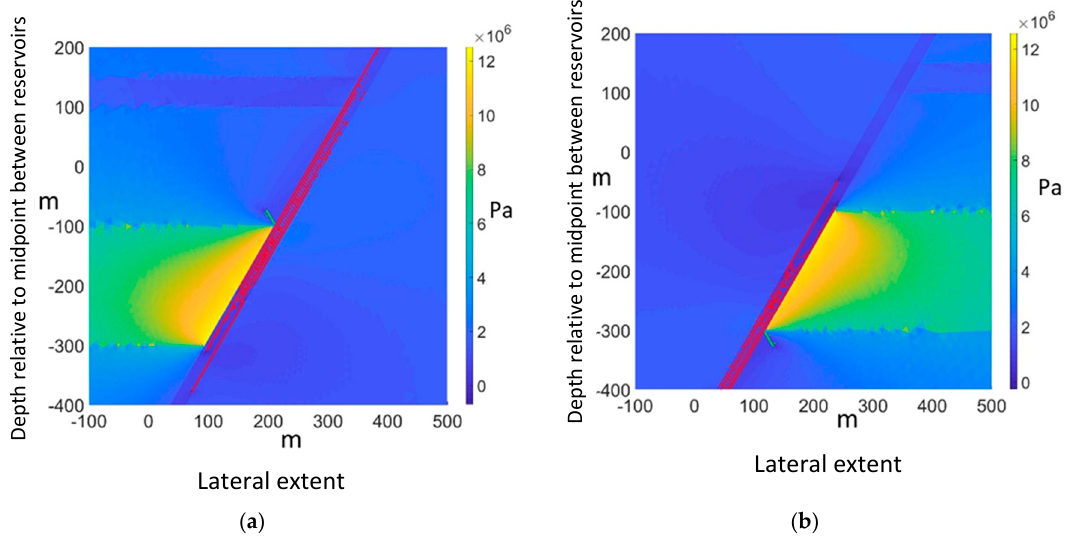
Figure 6. ( a ) For reservoirs in the hanging wall, shear fractures propagate all the way up to the shallower reservoir when the depletion reaches 10 MPa (5 MPa pore pressure). The failed elements are shown in red; ( b ) For reservoirs in the footwall, the picture is reversed, with no breakthrough to the upper reservoir. Effective horizontal stress is plotted, scale in Pa.